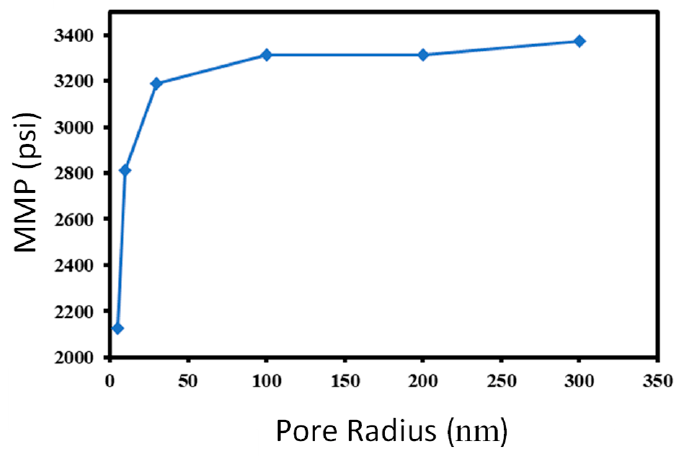
Figure 11. Base case fluid minimum miscibility pressure change with respect to pore radius.